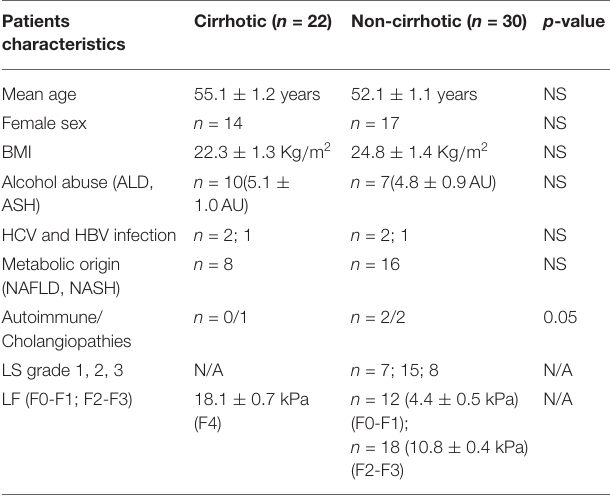
TABLE 1 | Anthropometric (body weight and BMI) and non-anthropometric data of the enrolled patients. Patients